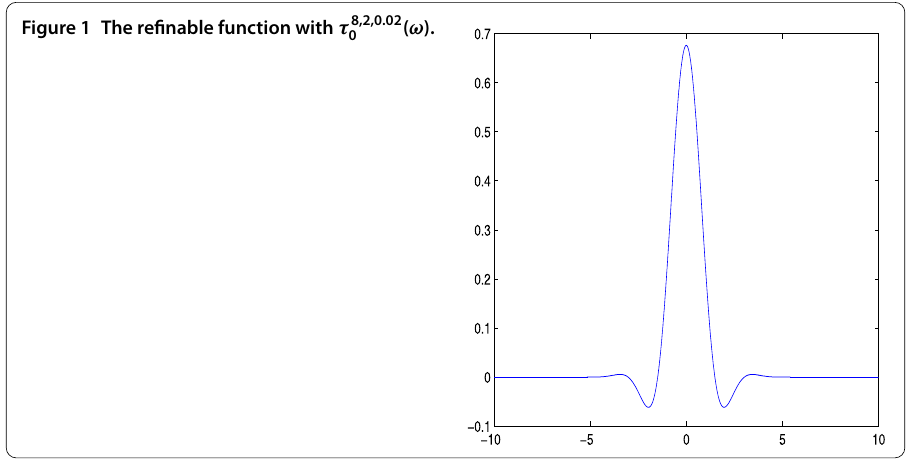
Table 3 Symmetric coefficients of the mask τ 16,3,0.01